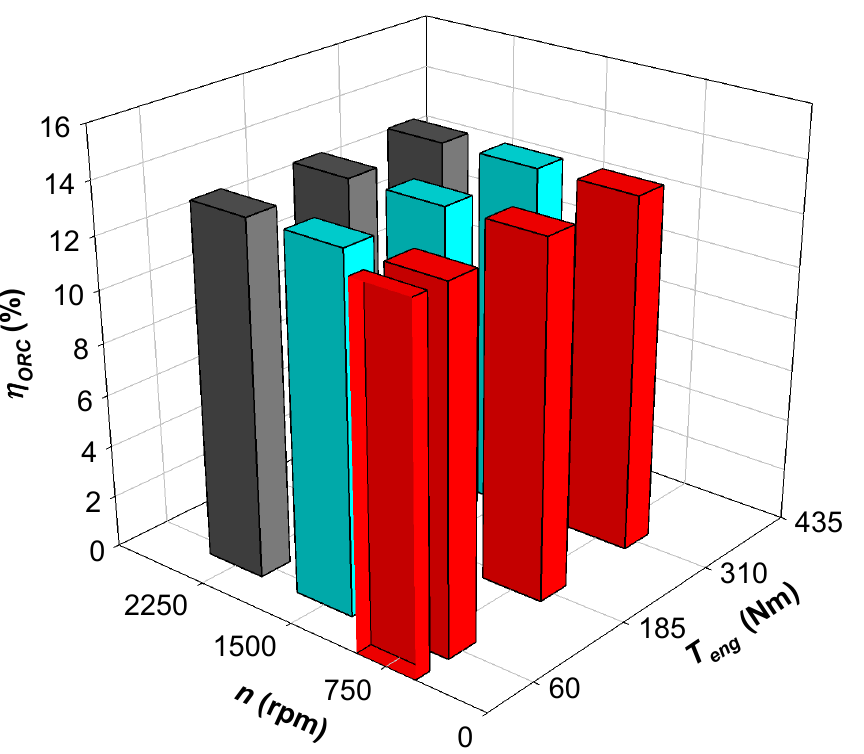
Figure 13. ORC efficiency at the engine operating points of the discretization grid.